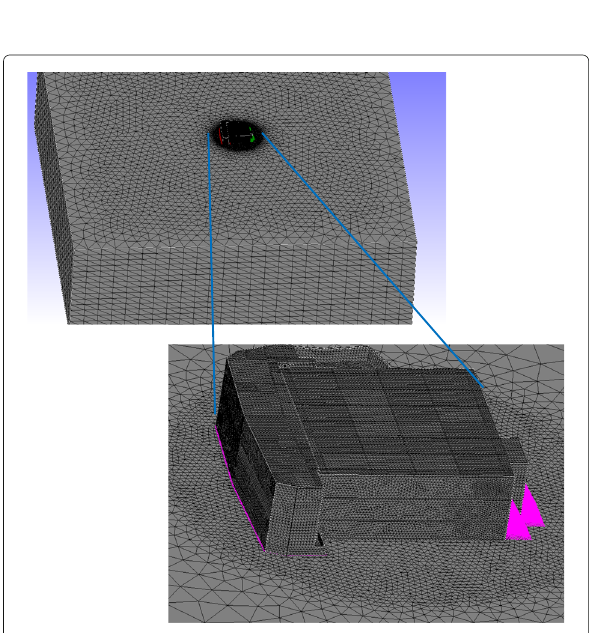
Fig. 11 Grid shape of the structure model FrontISTR++ used in the seismic model-structure model coupling. A grid representing a building is set at the center of the grid representing the